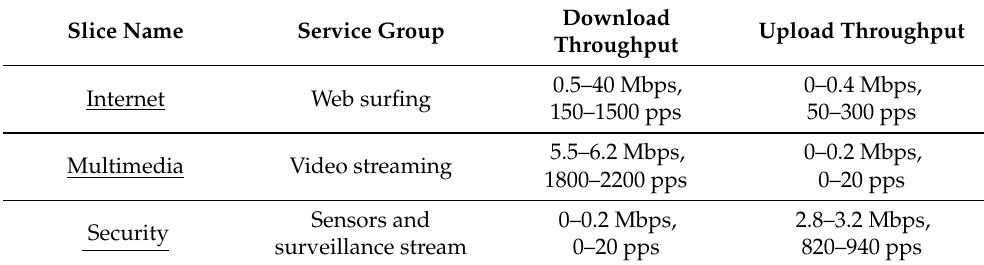
Table 1. Slice arrangement in